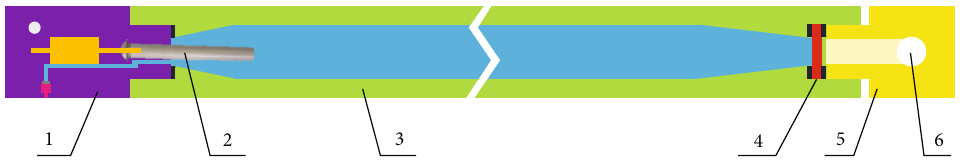
Figure 2: L-CO cracker composition. 1: in fl ator head; 2: exciter; 3: reservoir tube; 4: blasting disc; 5: blasting head; 6: vent. 2